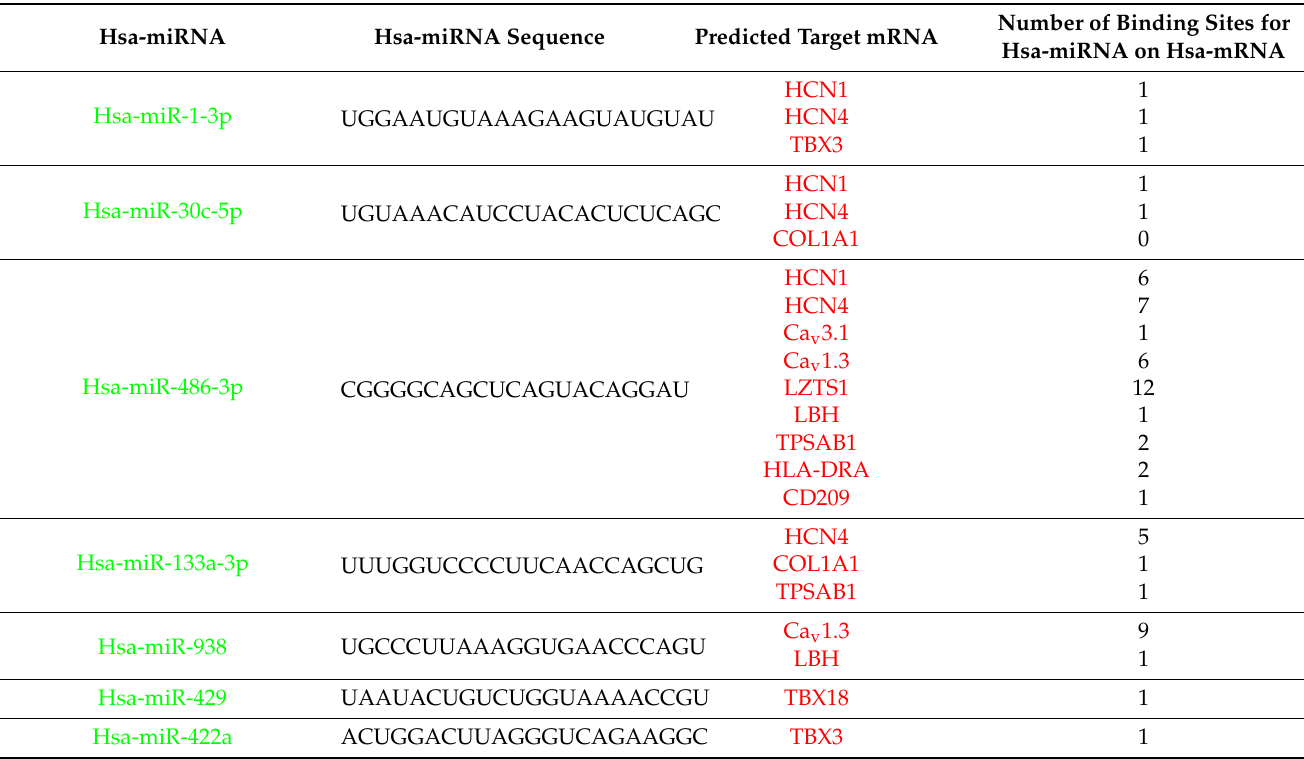
Table 1. Predicted microRNA-mRNA interactions. MicroRNA expression data are based on our previous studies [4,10]. Significant change in the expression of mRNA and microRNA is classed as p ≤ 0.05. Red represents significantly more expressed mRNA in the SN vs. right atrium. Green represents significantly less expressed microRNA in the SN vs. right atrium. HCN1, HCN4, Ca v 1.3, and Ca v 3.1 are pacemaking ion channels (see text for details); LZTS1, LBH, TBX3, and TBX18 are transcription factors; COL1A1 is a collagen marker; TPSAB1 is a mast cell marker; HLA-DRA is histocompatibility complex marker; and CD209 is a macrophage cell marker. N = no; Y = yes; Hsa = homosapien. Number of Binding Sites for Hsa-miRNA Hsa-miRNA Sequence Predicted Target mRNA Hsa-miRNA on